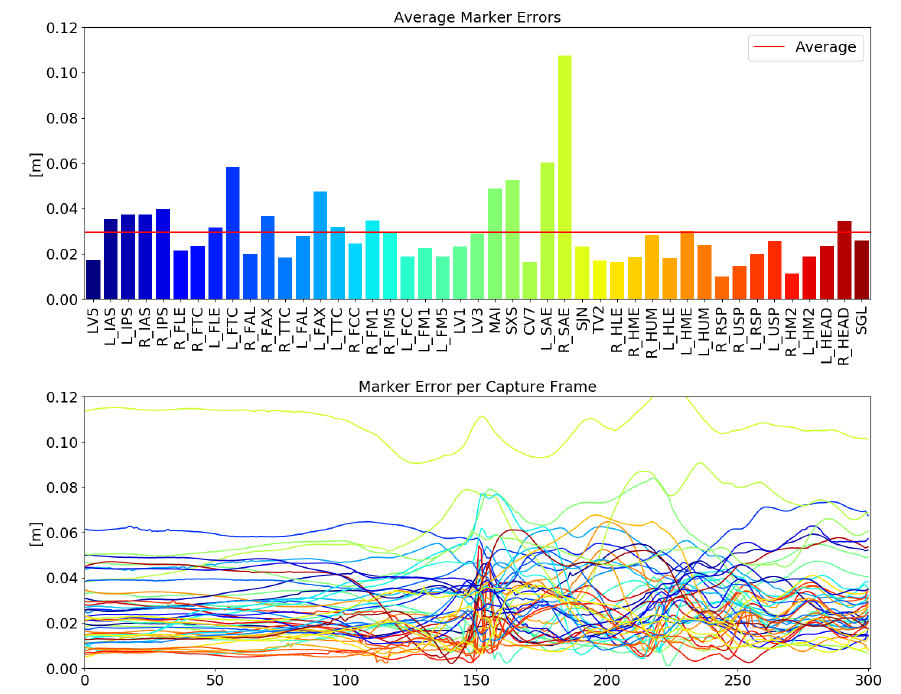
Figure 6. Top: Average marker error for all 45 markers. Largest deviations occur for the shoulder markers. This is due to the fact that the model is based on a N-Pose capture and the slackline motion mainly had a T-Pose like arm positioning. Bottom: Frame by frame marker